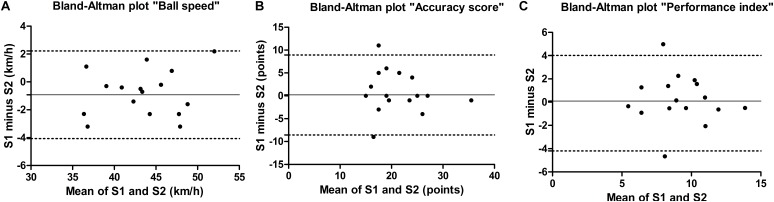
Bland–Altman plots for (A) ball speed, (B) accuracy score, and (C) performance index. The continuous line represents the mean difference between the first series of the first session (S1) and the second series of the first session (S2). The dotted lines represent the 95% limits of agreement (n = 16).